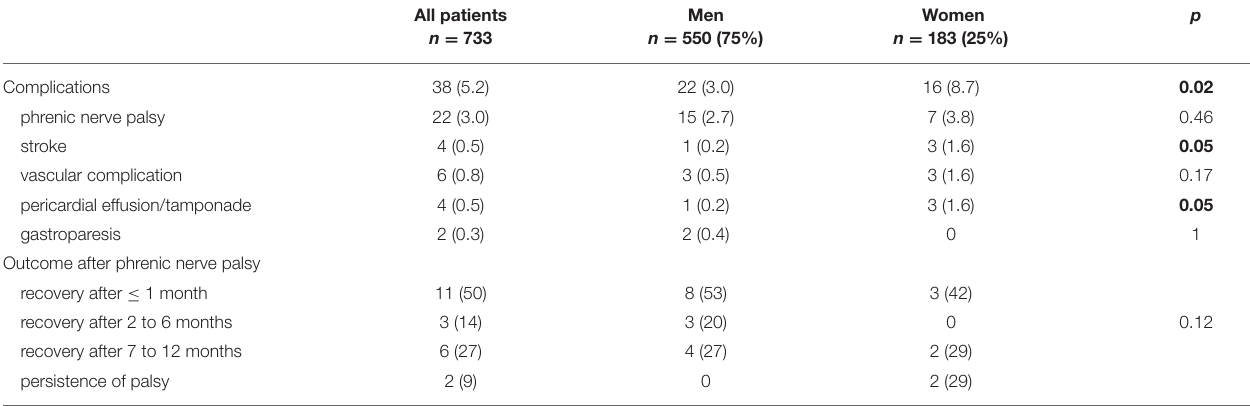
TABLE 2 | Complications.